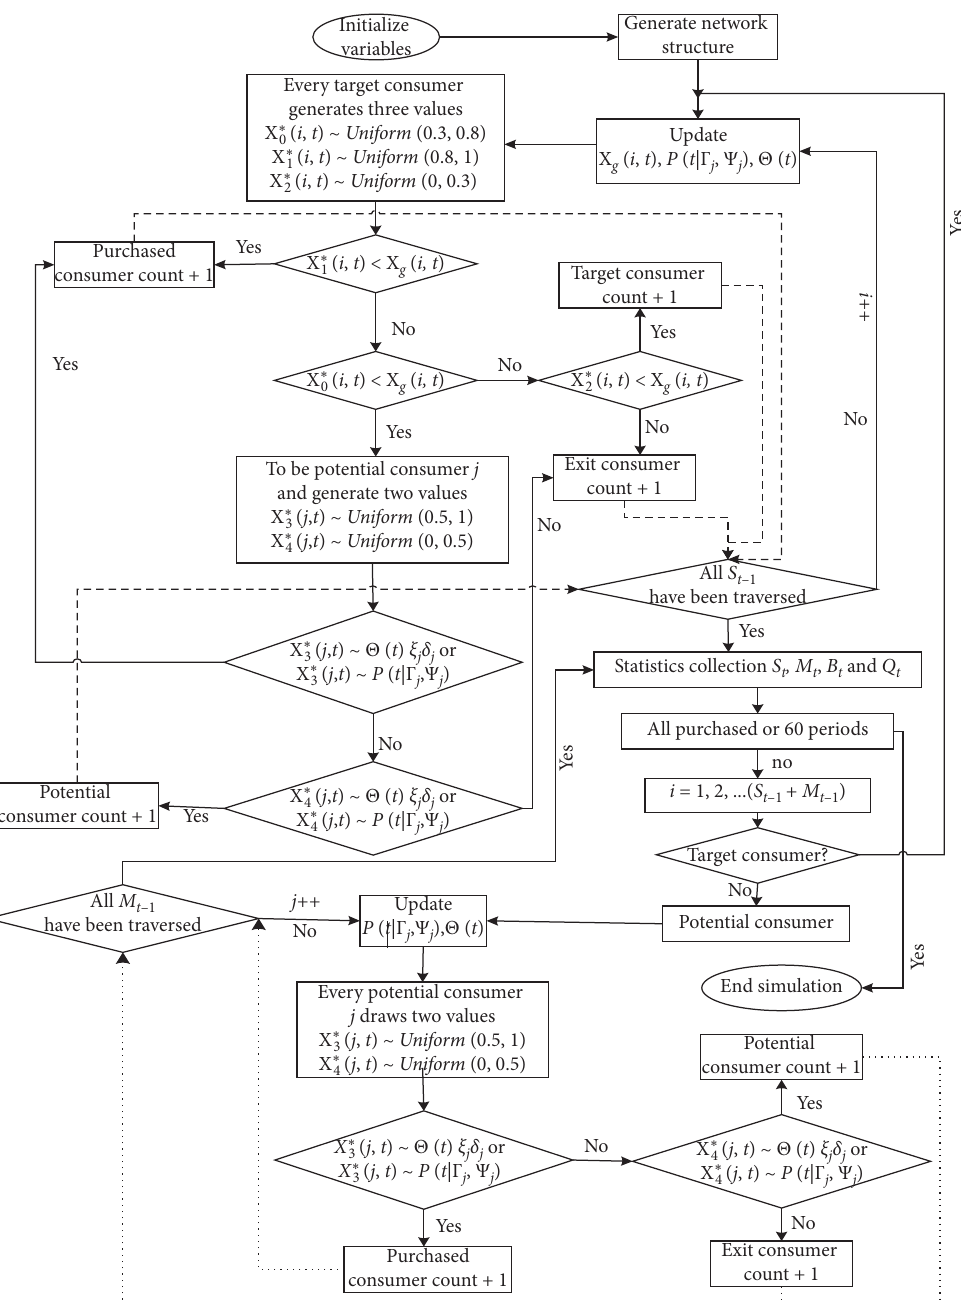
Figure 6: Overview of the simulation process under the coupling